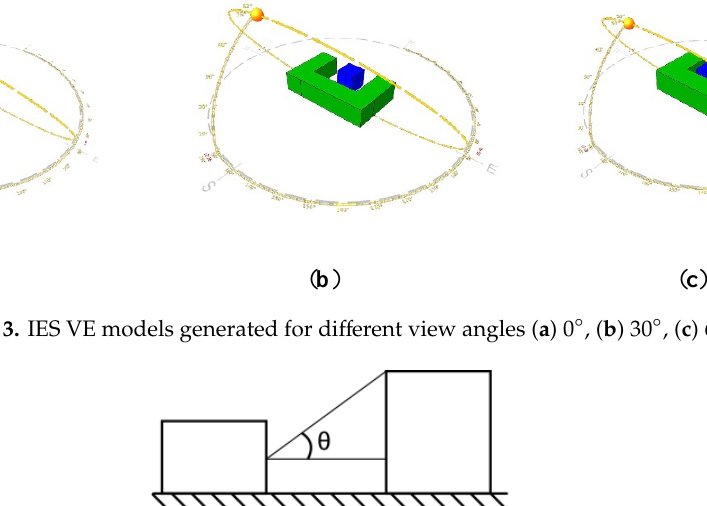
Figure 4. View angle to identify the presence of external obstructions limiting the solar radiation.